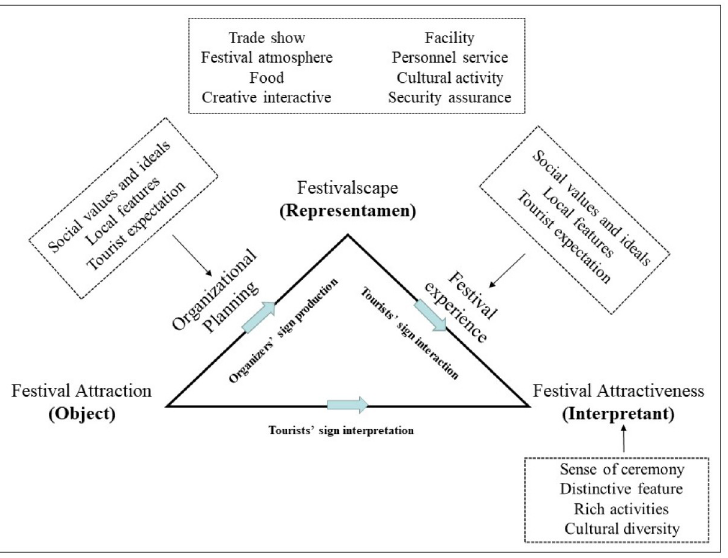
Fig 4. Conceptual model of semiotic construction of festival attraction